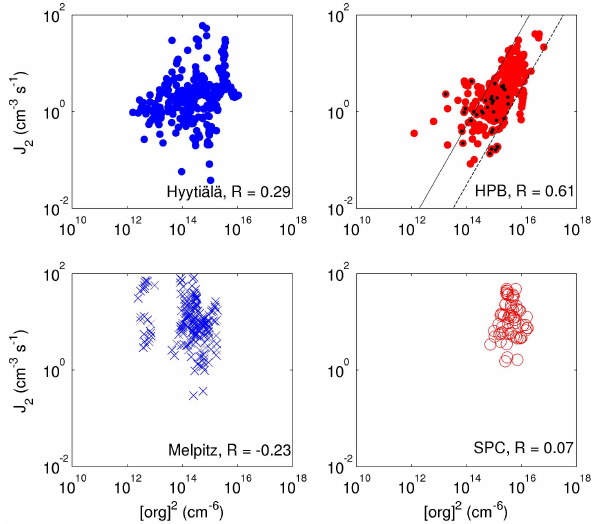
Fig. 6. Neutral particle formation rate J 2 as a function of squared low-volatility organic vapour concentration separately at the mea- surement sites. In the Hohenpeissenberg plot (upper right) the black points indicate the data recorded between April and July, whereas at the other sites all the data are from these months. The lines in Hohenpeissenberg plot present the site-specific 90th and 10th per- centile values of the coefficient K org (Eq. 13), 5.1 × 10 − 15 and 3.1 × 10 − 16 cm 3 s − 1 , respectively.